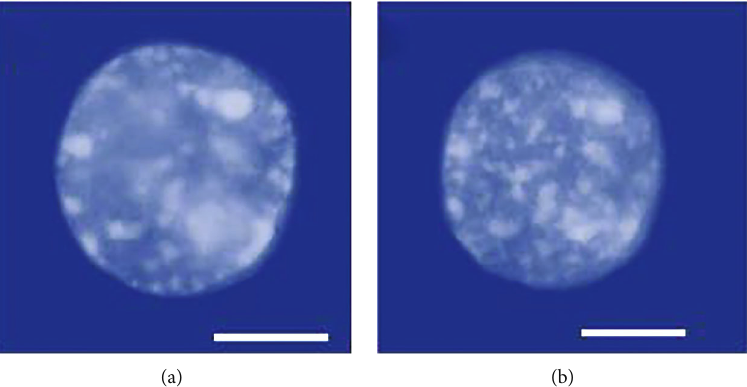
Figure 6: Di ff erent nuclear morphologies are present in the fl oating fraction of the cell culture after exposure to Mix 300 for 24 hours. (a, b) Interphase nucleus analysed in di ff erent focal planes showing highly positive punctate regions after labeling with Hoechst 33258. Bar 5 μ